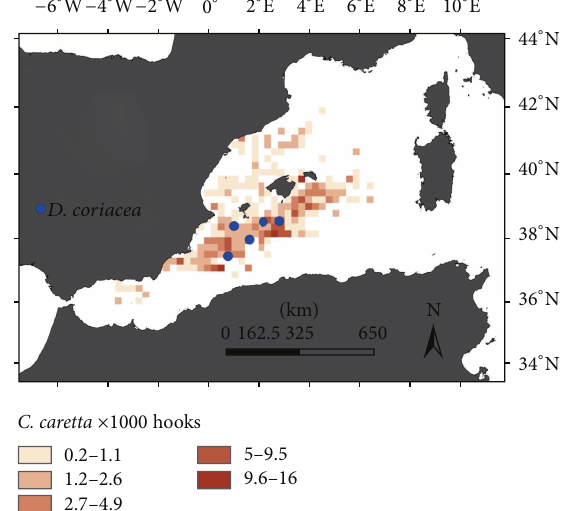
Figure 2: Distribution of bycatches of loggerhead (coloured scale) and leatherback turtle (blue